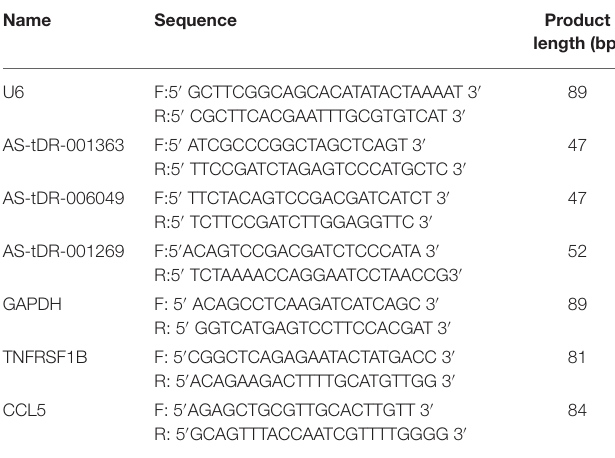
TABLE 2 | Sequences of primers for qPCR validation.